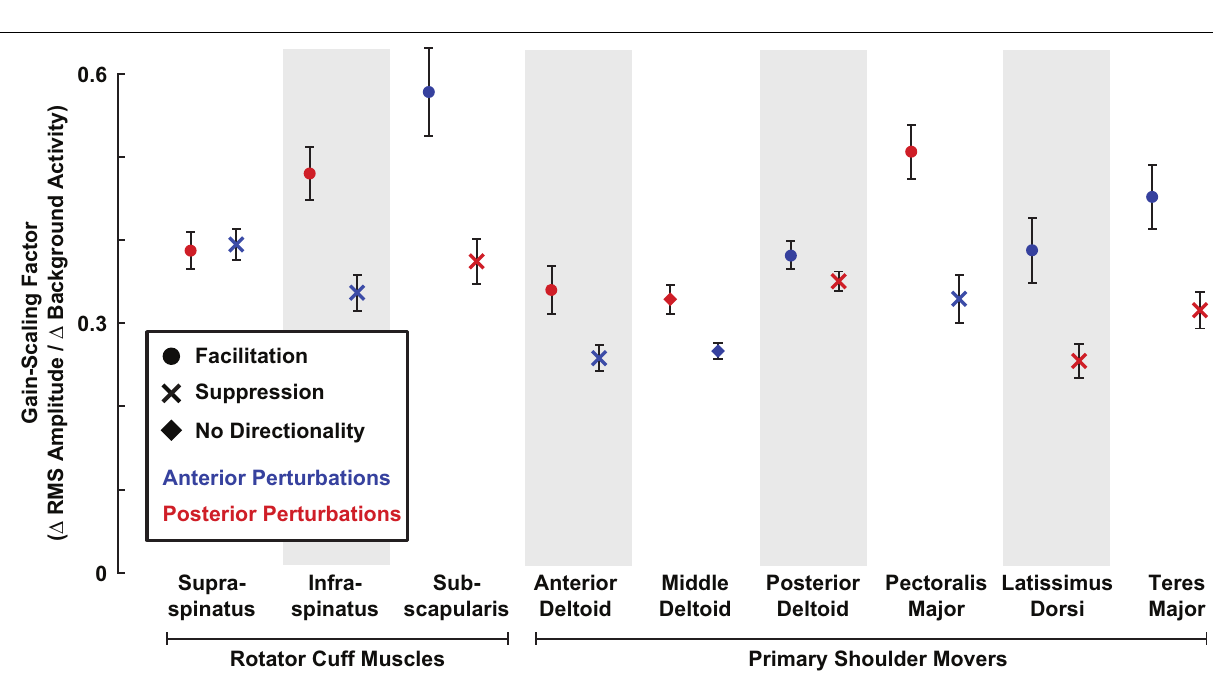
Frontiers in Integrative Neuroscience |